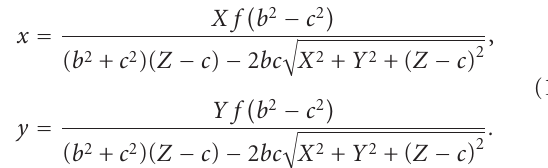
( X m , Y m ) ( t − d t ) and ( X m , Y m ) ( t ) by referring to the